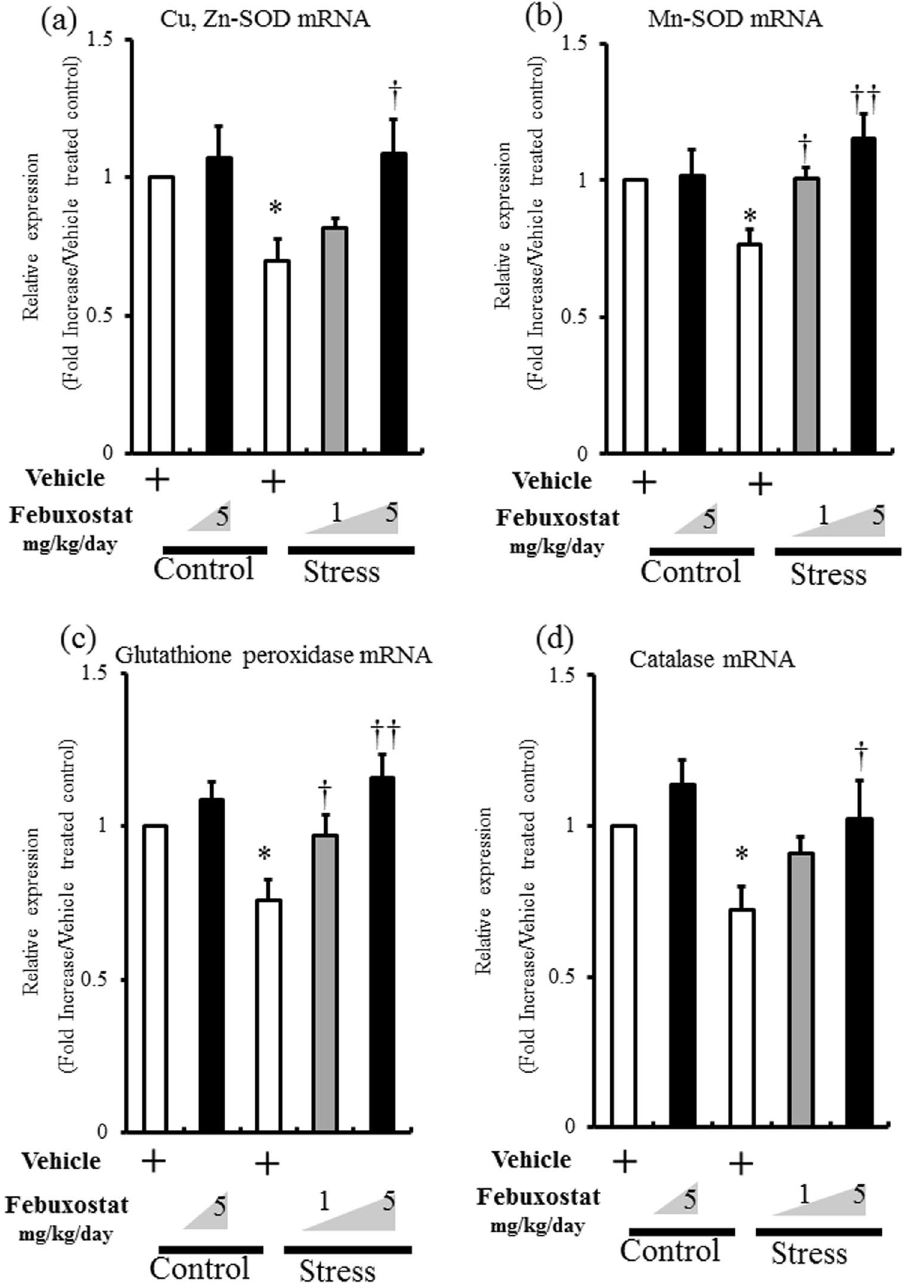
Figure 4. Febuxostat abrogates stress-induced decrease in antioxidant enzymes. The mRNA expression levels of antioxidant enzymes in inguinal adipose tissue of control mice treated with vehicle or febuxostat (5 mg/kg/ day), and stressed mice treated with vehicle or febuxostat (1 or 5 mg/kg/day) were analyzed by quantitative RT- PCR ( a–d ). Values are expressed relative to the vehicle-treated control mice. Data were analyzed by Student’s t-test and displayed as mean ± SD of 5–6 mice per group. ( a ) Cu, Zn-SOD mRNA expression in adipose tissue. * P < 0.02, compared with the vehicle-treated control mice, † P < 0.04, compared with the vehicle-treated stressed mice. ( b ) Mn-SOD mRNA expression in adipose tissue. * P < 0.04, compared with the vehicle-treated control mice, † P < 0.04 and †† P < 0.002, compared with the vehicle-treated stressed mice. ( c ) Glutathione peroxidase mRNA expression in adipose tissue. * P < 0.04, compared with the vehicle-treated control mice, † P < 0.04 and †† P < 0.002, compared with the vehicle-treated stressed mice. ( d ) Catalase mRNA expression in adipose tissue. * P < 0.01, compared with the vehicle-treated control mice, † P < 0.02, compared with the vehicle-treated stressed